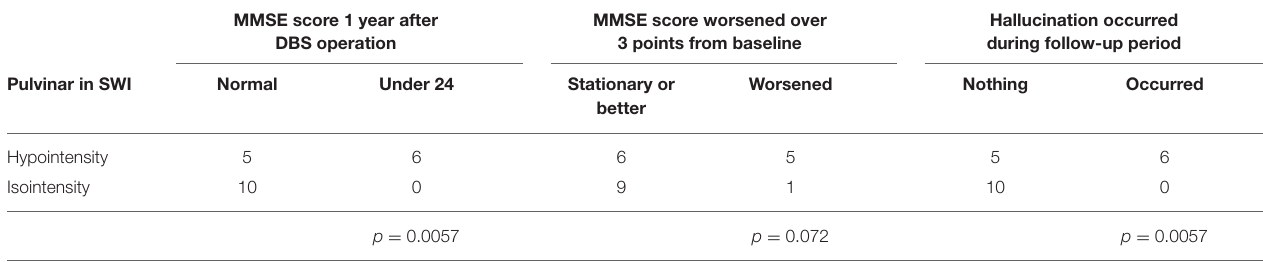
TABLE 2 | Relationship between cognitive function and pulvinar hypointensity in SWI. MMSE score 1 year after DBS operation